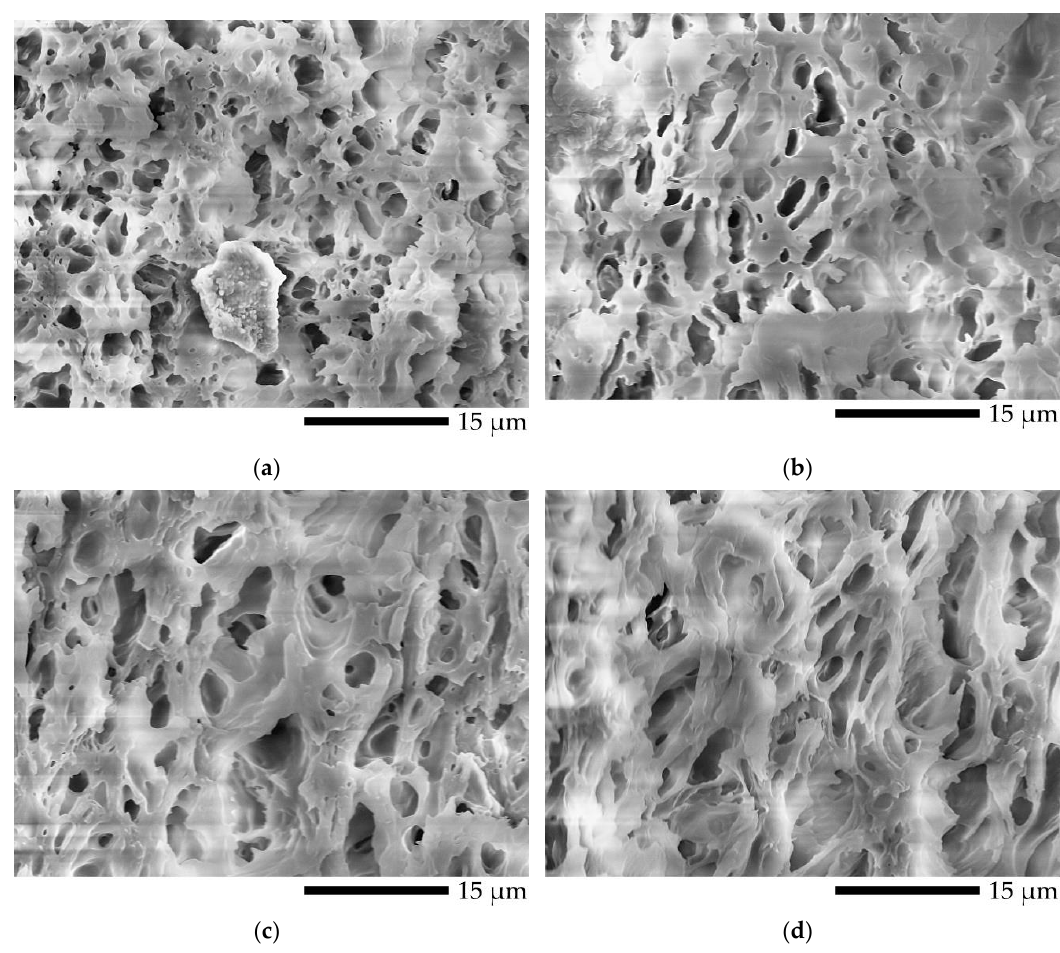
Figure 11. Co-continuous porous of L5V5 at different location at etching time of 7 days: ( a ) (I) location in TD; ( b ) (II) location in TD; ( c ) (I) location in FD; and ( d ) (II) location in FD.